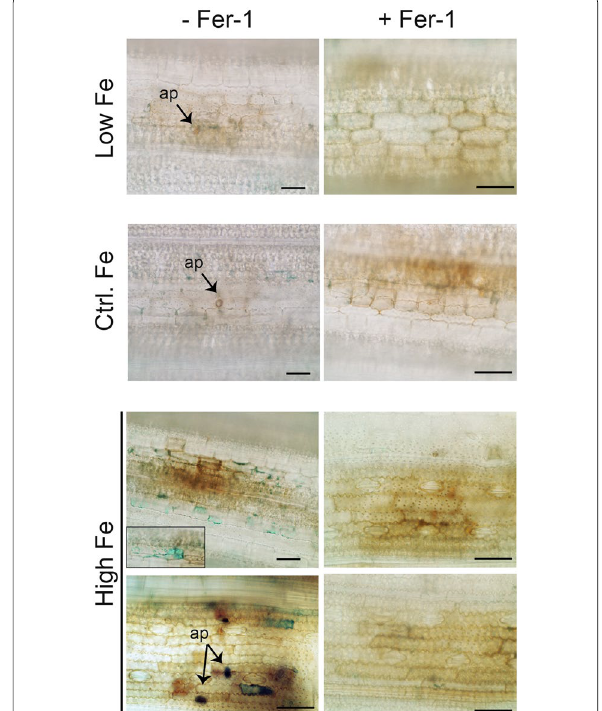
Fig. 9 Fe detection in leaves of Low‑Fe, Control‑Fe, and High‑Fe rice plants that have been inoculated with M. oryzae spores (48 hpi). Leaves were treated with the ferroptosis inhibitor Ferrostatin (Fer‑1) ( Fer‑1) or not ( Fer‑1). Rice leaves (youngest developed leaves) + − were subjected to Perls staining for detection of Fe (blue color). The images shown are representative of two independent experiments. Bars correspond to 100